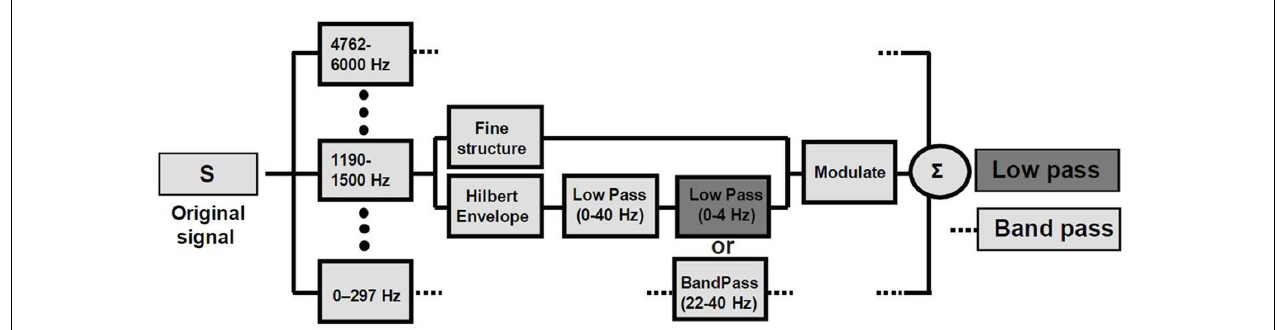
FIGURE 1 | Signal processing block diagram. Signals were low-pass filtered at 6 kHz and sampled at 16 kHz. The frequency spectrum of the speech signal was partitioned into 14 frequency bands with a linear-phase FIR filter bank (slopes 60 dB/100 Hz or greater), spanning the range 0.1 and 6 kHz, spaced in 1/3 octave steps (approximately critical band–wide) across the acoustic spectrum. The Hilbert transform was used to decompose the signal in each band into a slowly varying temporal envelope and a rapidly varying fine structure. The temporal envelope was subsequently low-pass filtered with a cutoff frequency of 40 Hz and then either low- (0–4 Hz; dark gray bar) or band- (22–40 Hz; light gray bar) pass filtered. The time delays, relative to the original signal, introduced by the filtering, were compensated by shifting the filter outputs. After the filtering, the envelope was combined with the carrier signal (fine structure) by multiplying the original band by the ratio between the filtered and original envelopes. The result for each original signal (S) are ‘Low Pass’ and ‘Band Pass’ conditions containing predominantly low or high modulation frequencies, respectively.